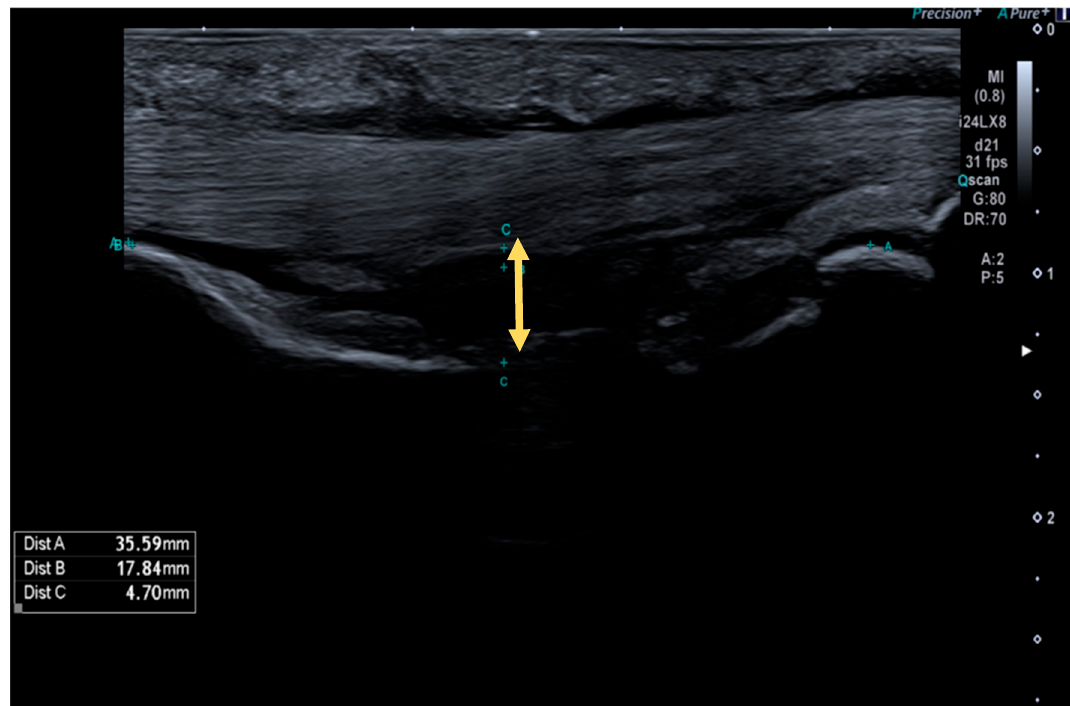
Figure 1. High-resolution ultrasound image of a complete A2 pulley rupture. The arrow indicates the tendon–bone distance (TBD) in the midpoint of the proximal phalange.